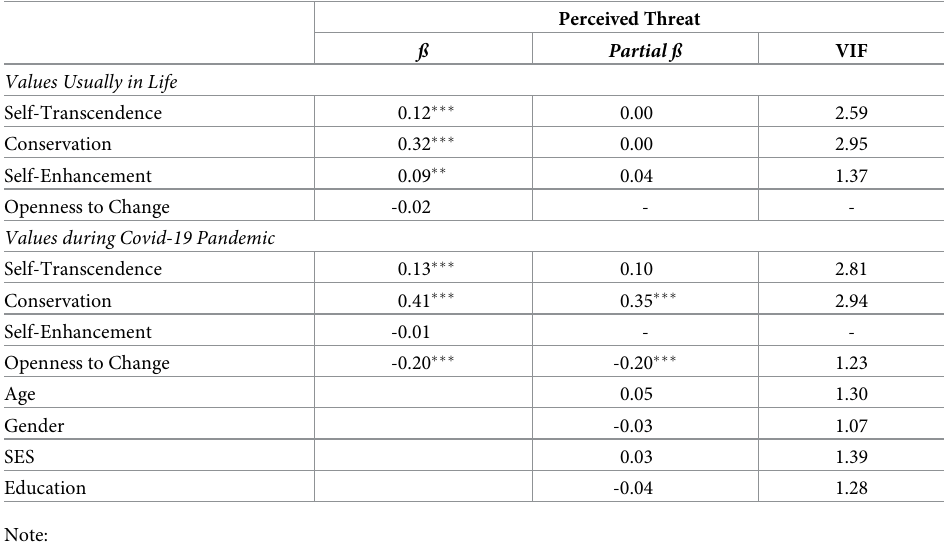
Table 4. Beta coefficients and partial coefficients (standardized) between perceived threat and Schwart’s